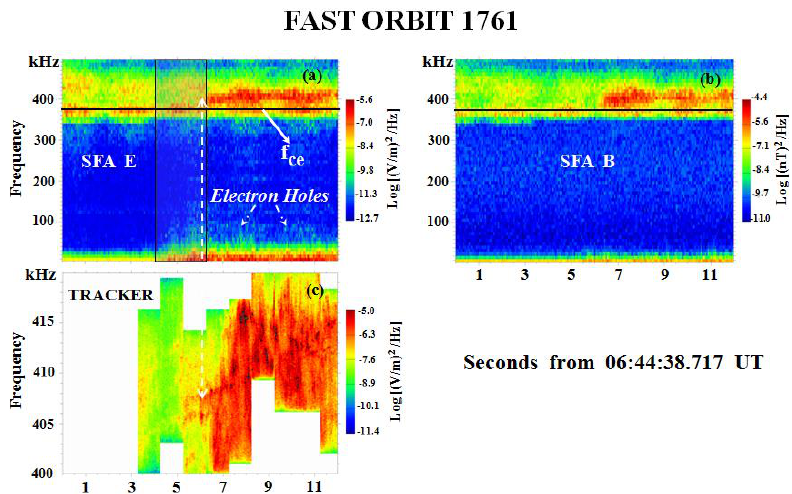
Figure 5. Electric (a) and magnetic (b) power frequency spectra measured by the onboard swept frequency analyser (SFA). The frequency spans 0 to 500kHz with a 4kHz bandwidth. The shaded blue region again corresponds to the extension of the measured DC parallel electric field. The dark horizontal line is the nonrelativistic electron gyrofrequency f ce . The electric power density (c) provided by the plasma wave tracker reveals the presence of large-amplitude fine spectral AKR features in close relation to the detection of EHs (initial time indicated by the broken white lines). The frequency axis goes from 400 to 420kHz with a 32Hz resolution. Note that the seconds from 06:44:38.717UT refer to the label for the lower